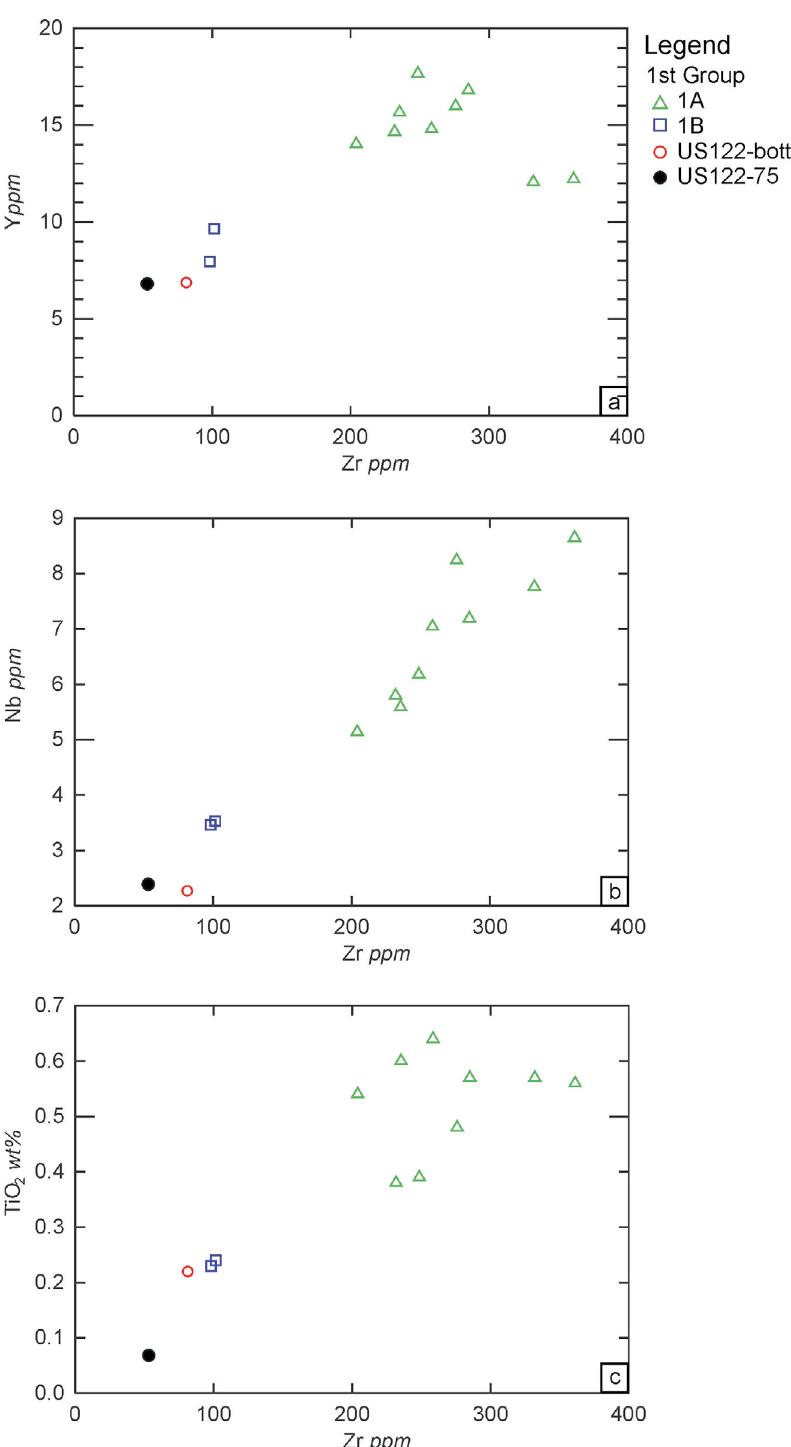
Figure 9: Binary diagrams for the first group glasses: a) Zr ppm vs. Y ppm; b) Zr ppm vs. Nb ppm c) Zr ppm vs. TiO